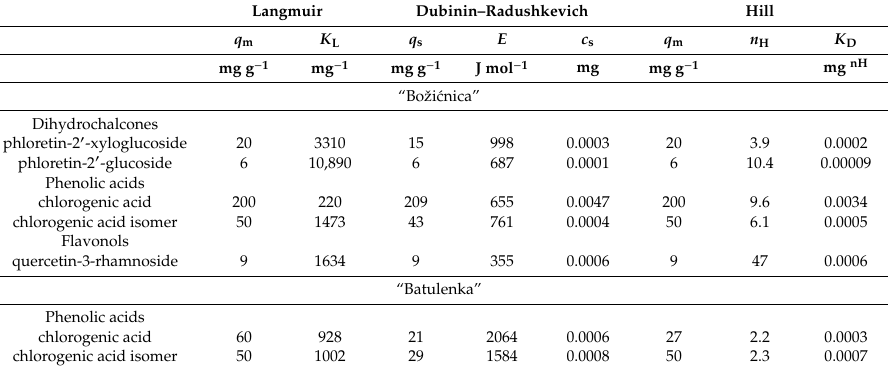
Table 3. Parameters of Langmuir, Dubinin–Radushkevich, and Hill adsorption isotherms obtained by improved non-linear modeling of adsorbed polyphenols from “Boži´cnica” and “Batulenka” flesh onto β